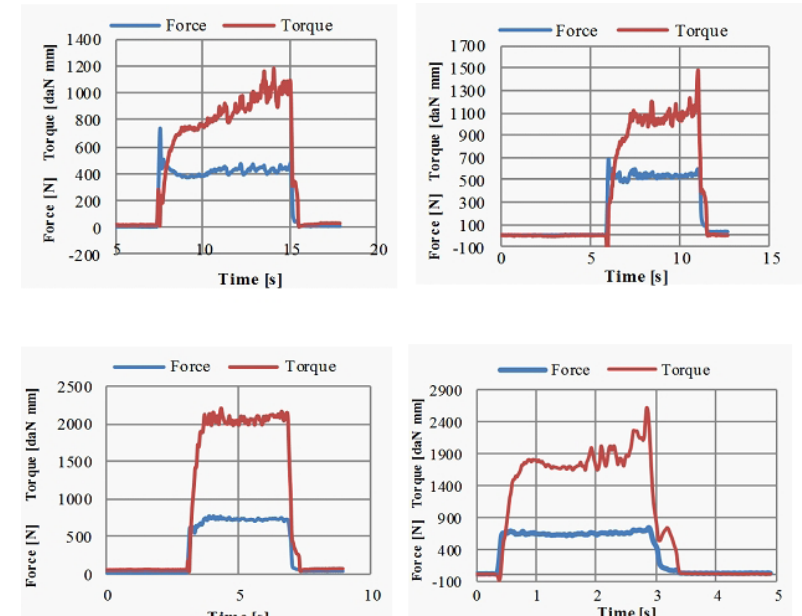
Figure 27. Obtained experimental results.